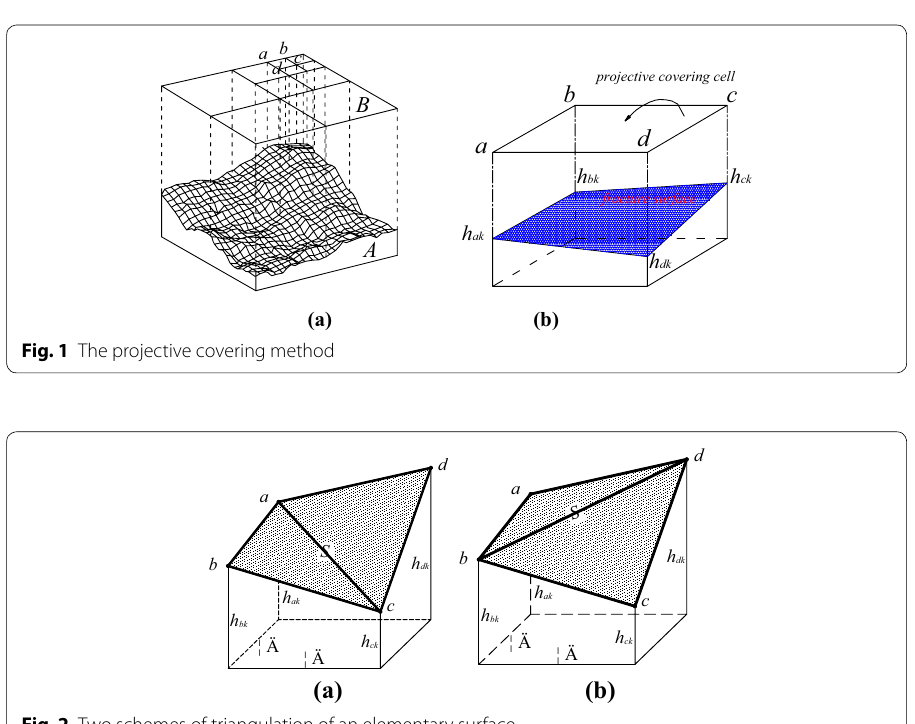
Fig. 2 Two schemes of triangulation of an elementary